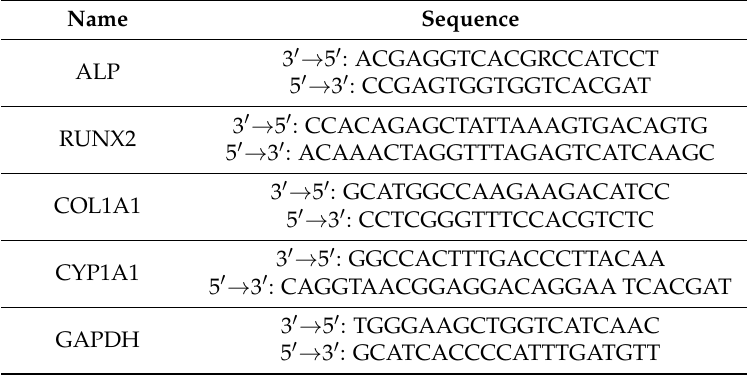
Table 1. Primer sequences used in the